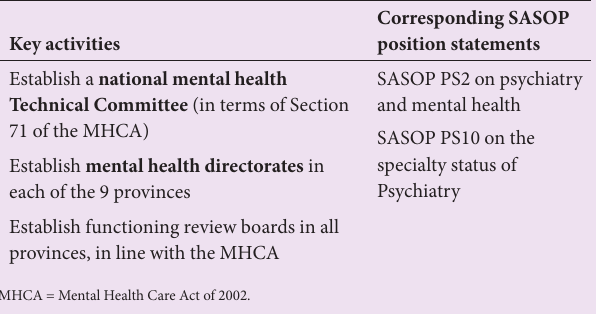
Table 2. National Objective 2: Institutional capacity (national, provincial,